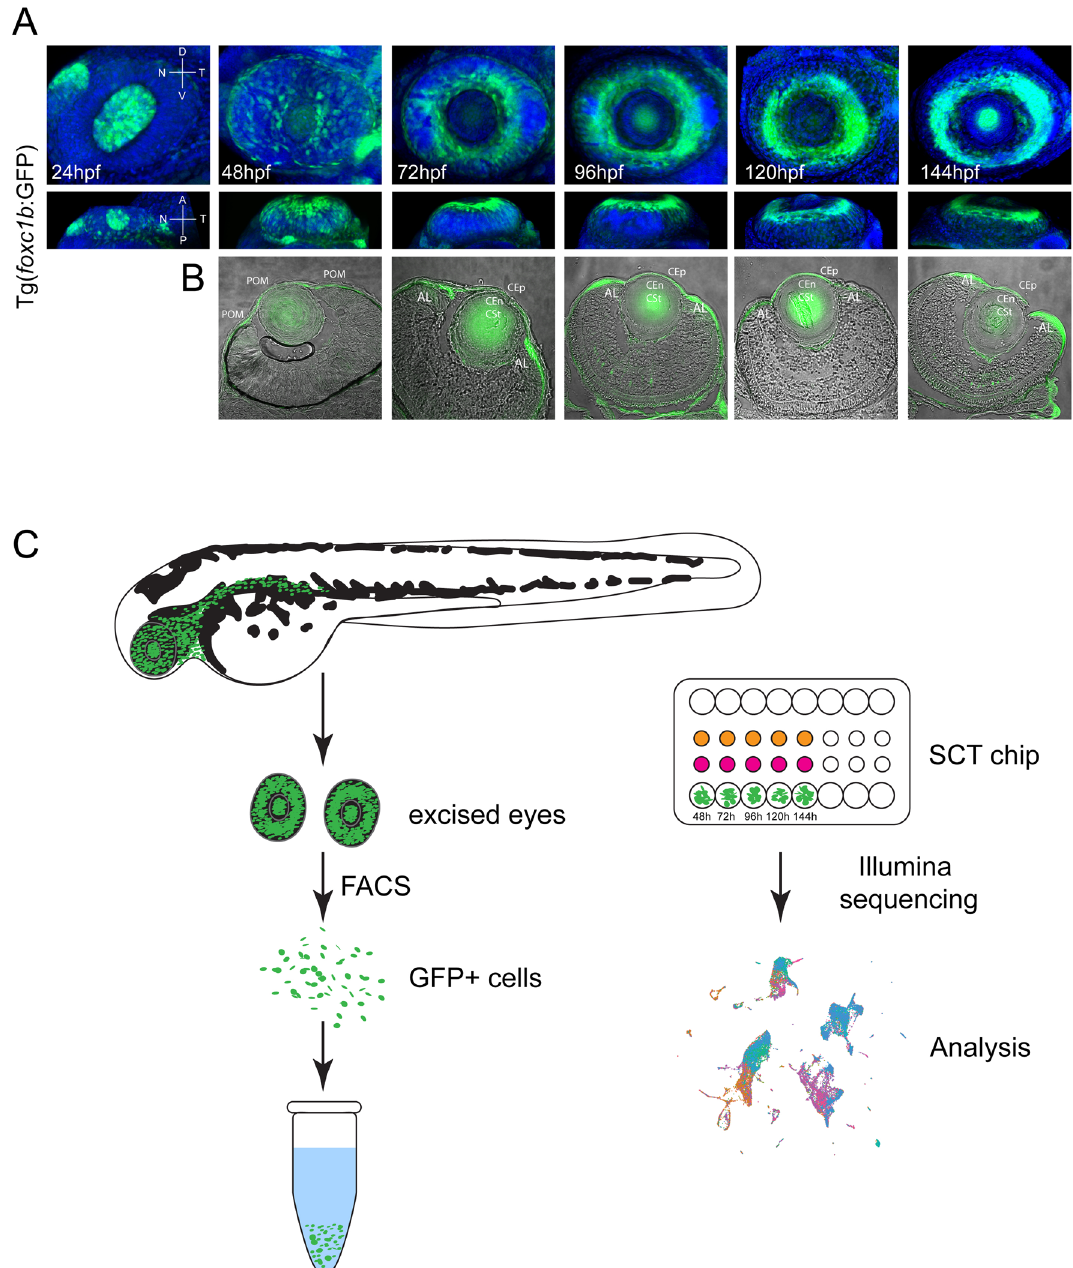
Figure 1. Strategy for generating ASM single cell transcriptomes over the course of early AS development. ( A ) Volume projections of ventral and dorsal views from 3D confocal stacks of whole mount Tg[ foxc1b :GFP] embryos at 24, 48, 72, 96, 120 and 144 hpf. GFP+ cells (green) can be seen populating the AS regions by 48 hpf and assembling the typical doughnut like AS localization pattern from 72-144 hpf. DAPI (blue) was used to stain for nuclei. ( B ) Cryosections of Tg[ foxc1b :GFP] embryos at 48, 72, 96, 120 and 144 hpf captured using confocal microscopy. GFP signal (green) is found in the AS regions in each of the time points. Transmitted light was used to capture tissue architecture. ( C ) Schematic for capture and subsequent assembly of single cell ASM transcriptomes. Dissected whole eyes were dissociated and GFP+ cells isolated using FACS. Subsequently single cells are captured using the 10X Genomics Chromium and the resulting single cell cDNA sequenced and